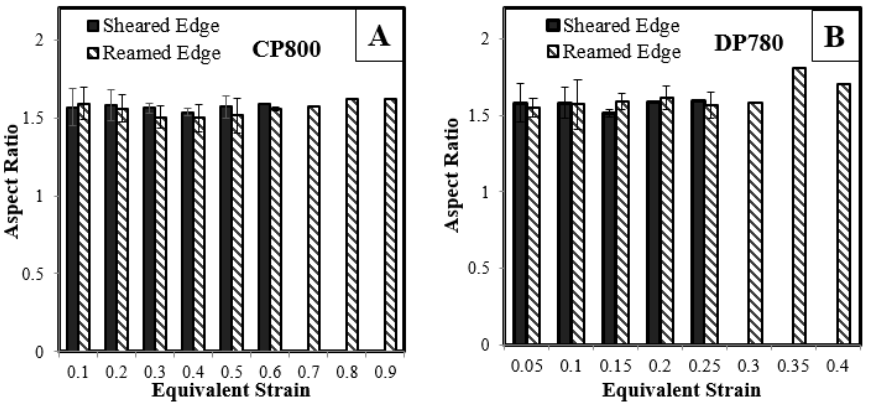
Figure 19. Variation of the average void aspect ratio for ( A ) CP800; and ( B ) DP780. Initially, voids can be aligned randomly in any direction. During deformation, voids tend to grow along the principal loading axes such that the void orientation becomes a function of void size as shown in Figure 20. The orientation of a void is defined as the angle of the major void axis with respect to the principal loading direction. Thomason et al. [45] stated that the orientation of a particle with respect to the direction of principal loading significantly influences damage evolution. The void orientation with respect to loading direction as a function of strain is shown in Figure 21. Since the average void diameter of the entire void population remains almost constant for DP780, the average orientation angle remains constant. In the CP800, a slight increase in void diameter is observed at higher strain, therefore the average void orientation decreases from 70° to 47°. The void